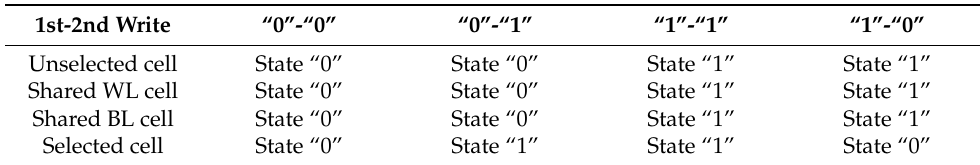
Figure 2. Transfer curve of poly-Si 1T-DRAM cell in simulations with ( a ) linear scale (inset, trap densities used in the simulations) and ( b ) log scale. Table 1. Simulated cases for each scenario.